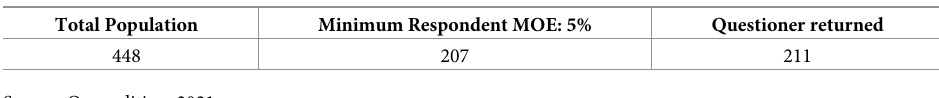
Table 1. Response